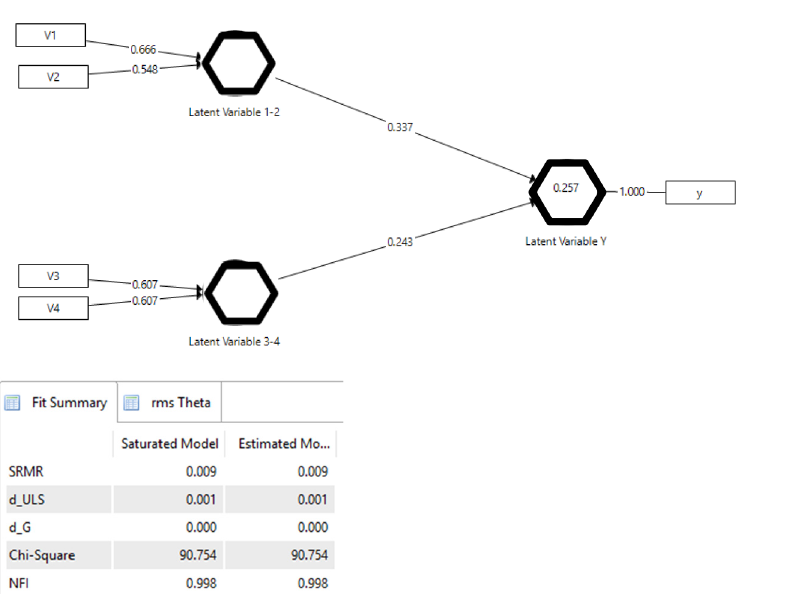
Figure 4. PLS “standardised paths coefficients”, “standardised outer weights”, R2adj of “latent variable Y” and the “model fit” in SmartPLS